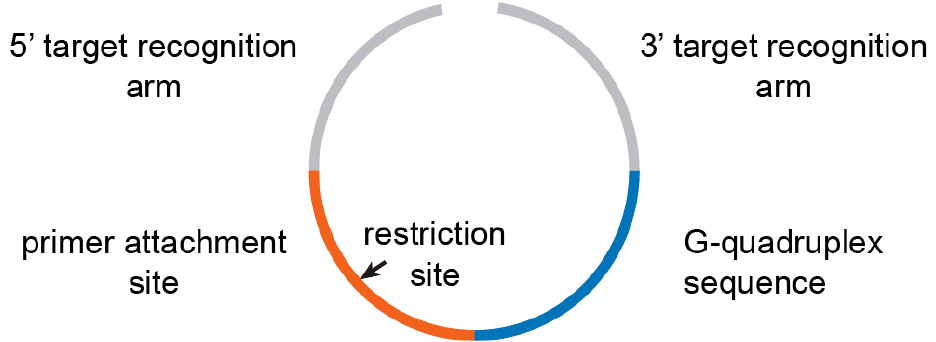
Figure 2. G-quadruplex padlock probes contain two terminal target recognition arms to the target of interest, a primer binding site with a restriction site, and a G-quadruplex sequence.